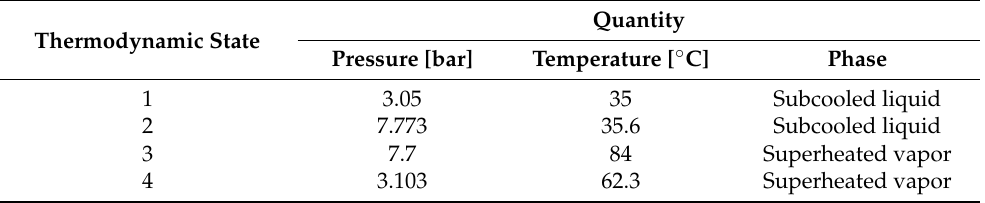
Table 4. Organic Rankine Cycle: Thermodynamic states used for the model. Thermodynamic State